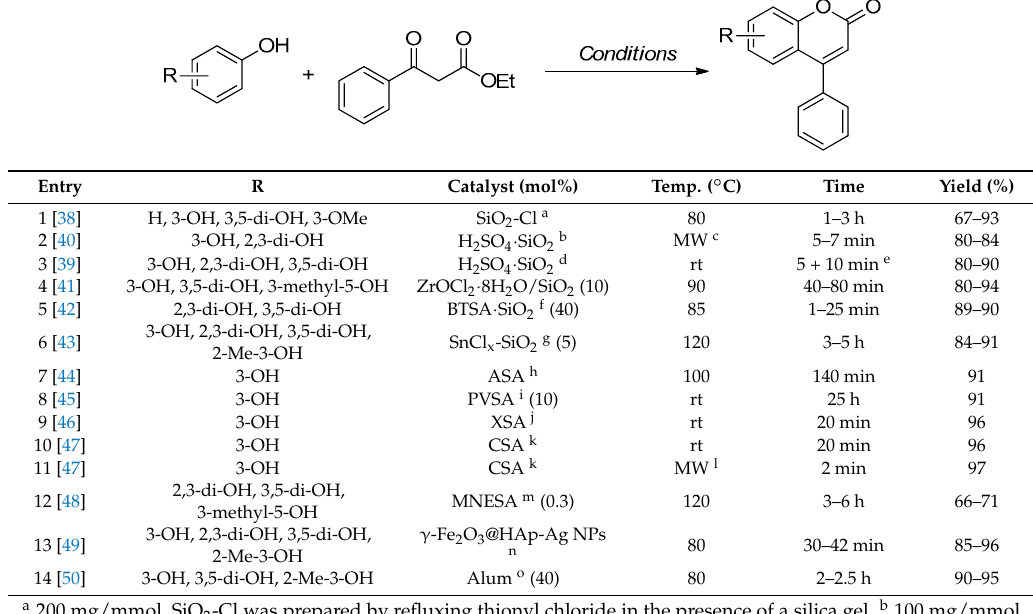
Table 2. Solvent-free Pechmann condensation with solid-supported catalysis.